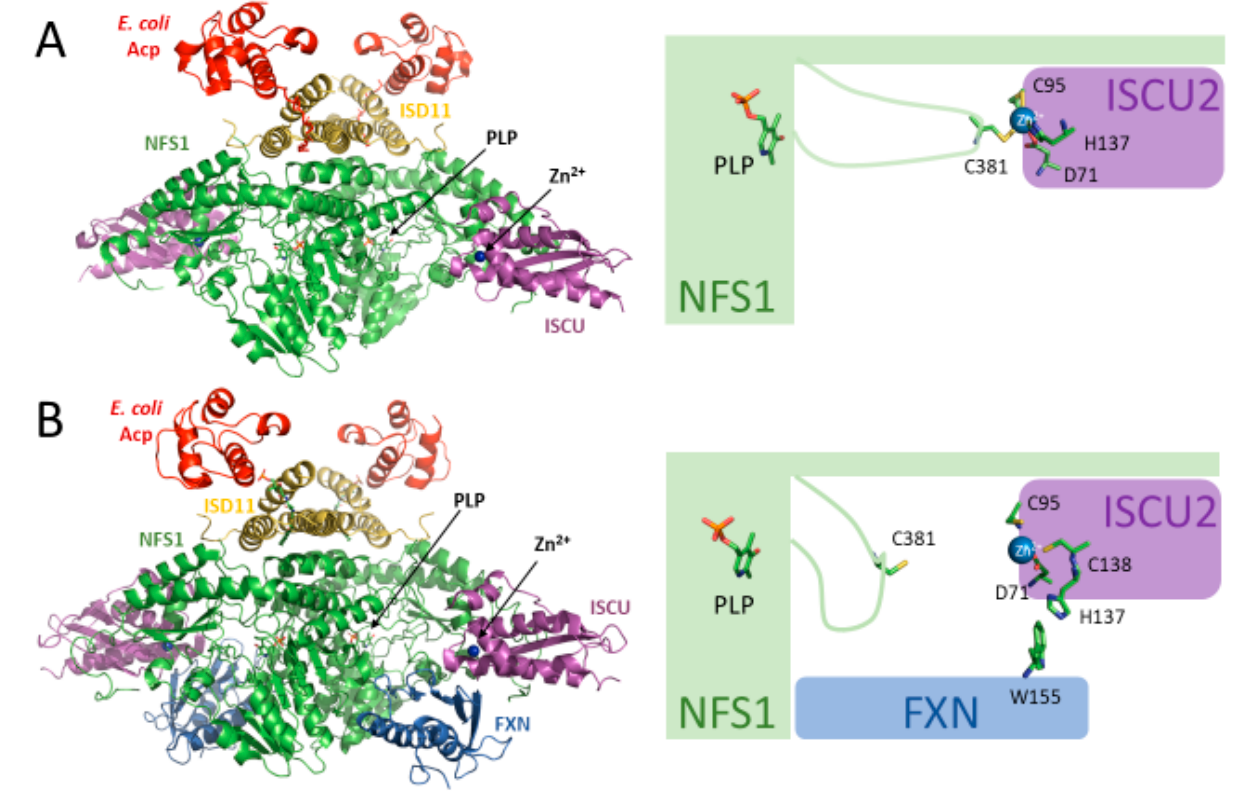
Figure 2. The (SDAU) 2 and (SDAUF) 2 structures in the presence of zinc. ( A ) Crystal structure of (SDAU) 2 complex in the presence of Zn 2+ (5WLW, [22]). In this structure, Zn 2+ is ligated by residues Asp71, Cys95, and His137 of ISCU2 and Cys381 of the NFS1 flexible loop. Cys381 is the catalytic residue implicated in the transfer of persulfide from NFS1 to ISCU2. ( B ) Cryo-EM structure of the (SDAUF) 2 complex in the presence of Zn 2+ (6NZU, [21]). In this structure, FXN residue Trp155 interacts with ISCU2 His137, and instead ISCU2 Cys138 binds to Zn 2+ . NFS1 Cys381 does not bind to Zn 2+ in this structure and is therefore free to perform its catalytic activity.